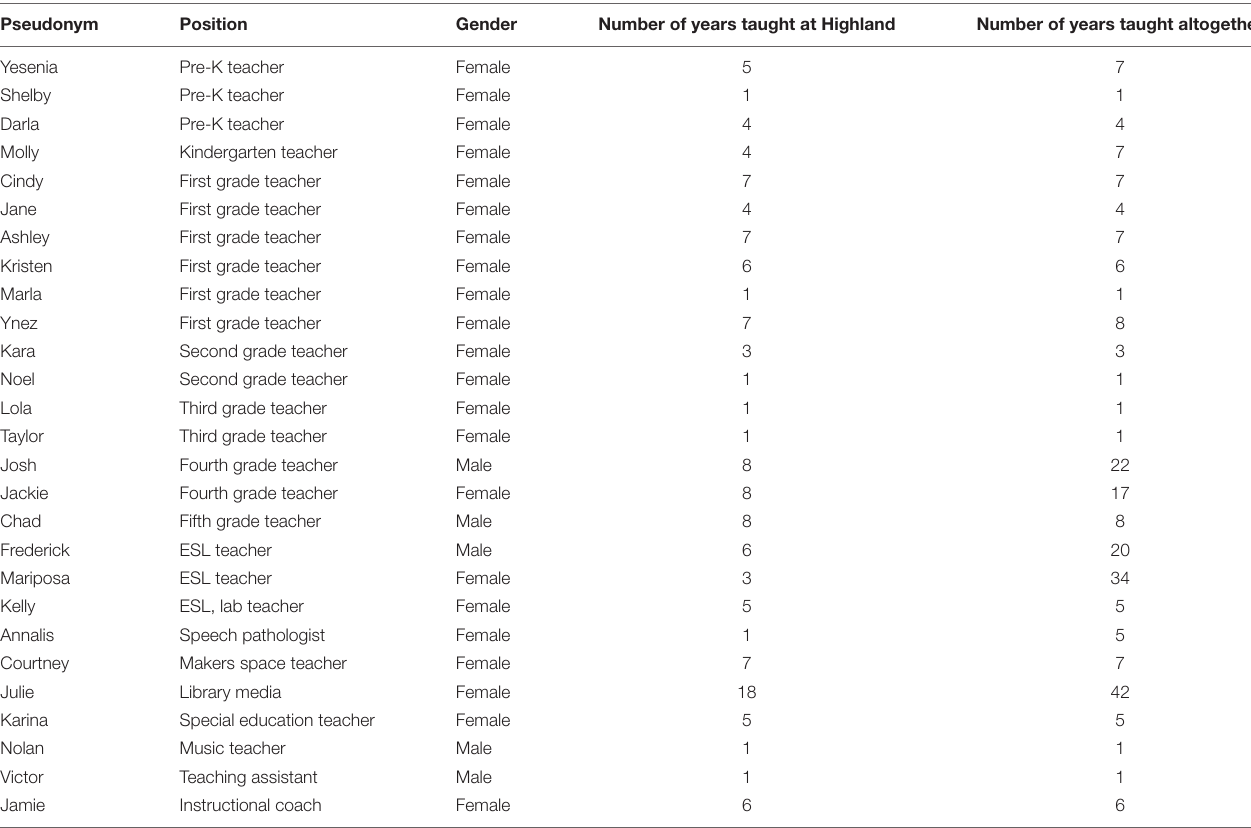
TABLE 1 | Participants’ background information.